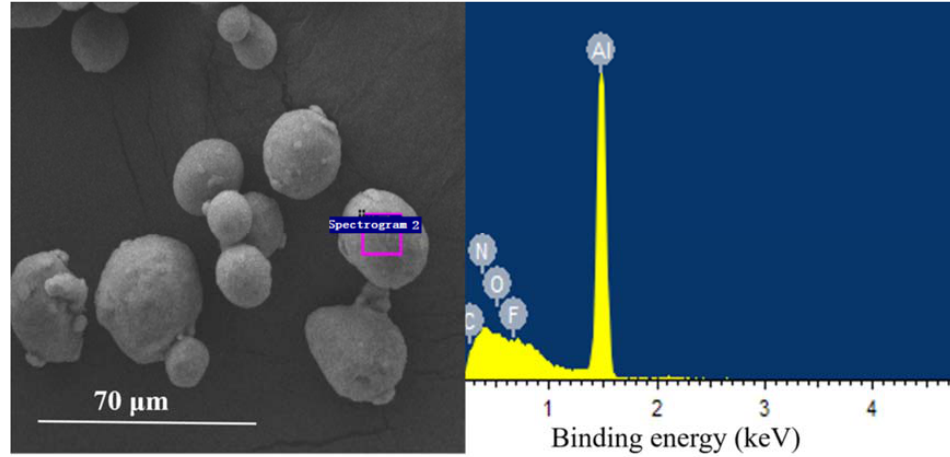
Figure 4. SEM image and EDS spectra of explosive 1.